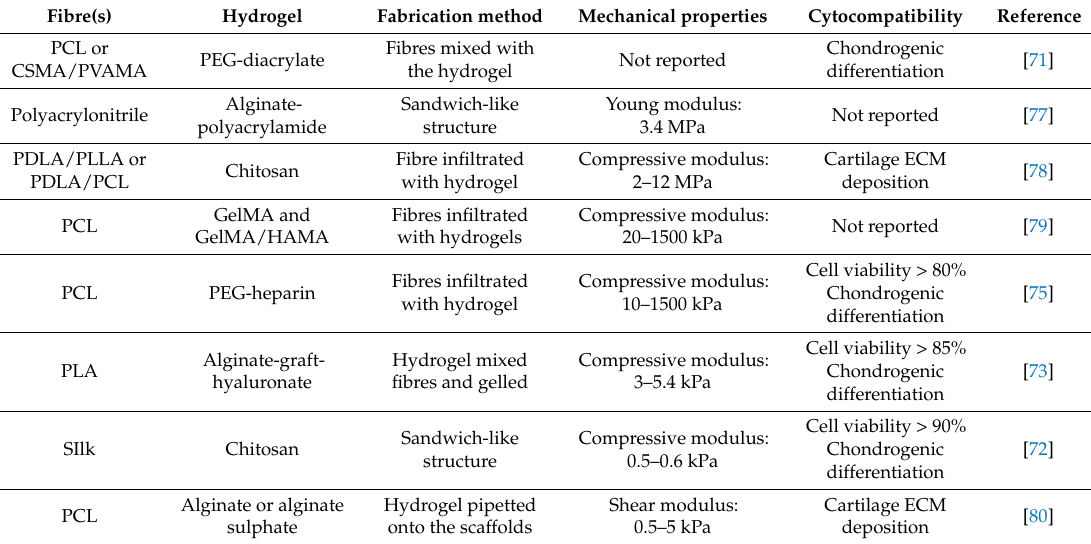
Table 1. Publications on electrospun fibres reinforced hydrogels for cartilage regeneration.